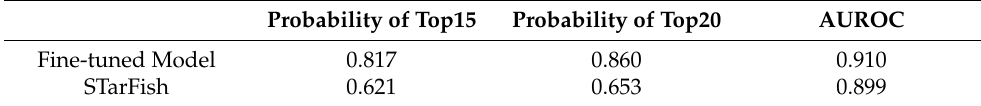
Table 3. Comparison between the fine-tuned model and STarFish.